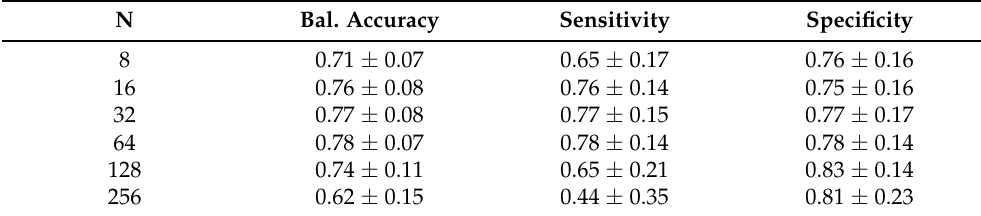
Table 2. Average M-mode image classification performance metrics with standard deviations of ResNet18 with different numbers of input frames. (N: Number of frames; Slice sel.: Slice selection method according to Section 2.2.2; Bal. Accuracy: Balanced accuracy.) N